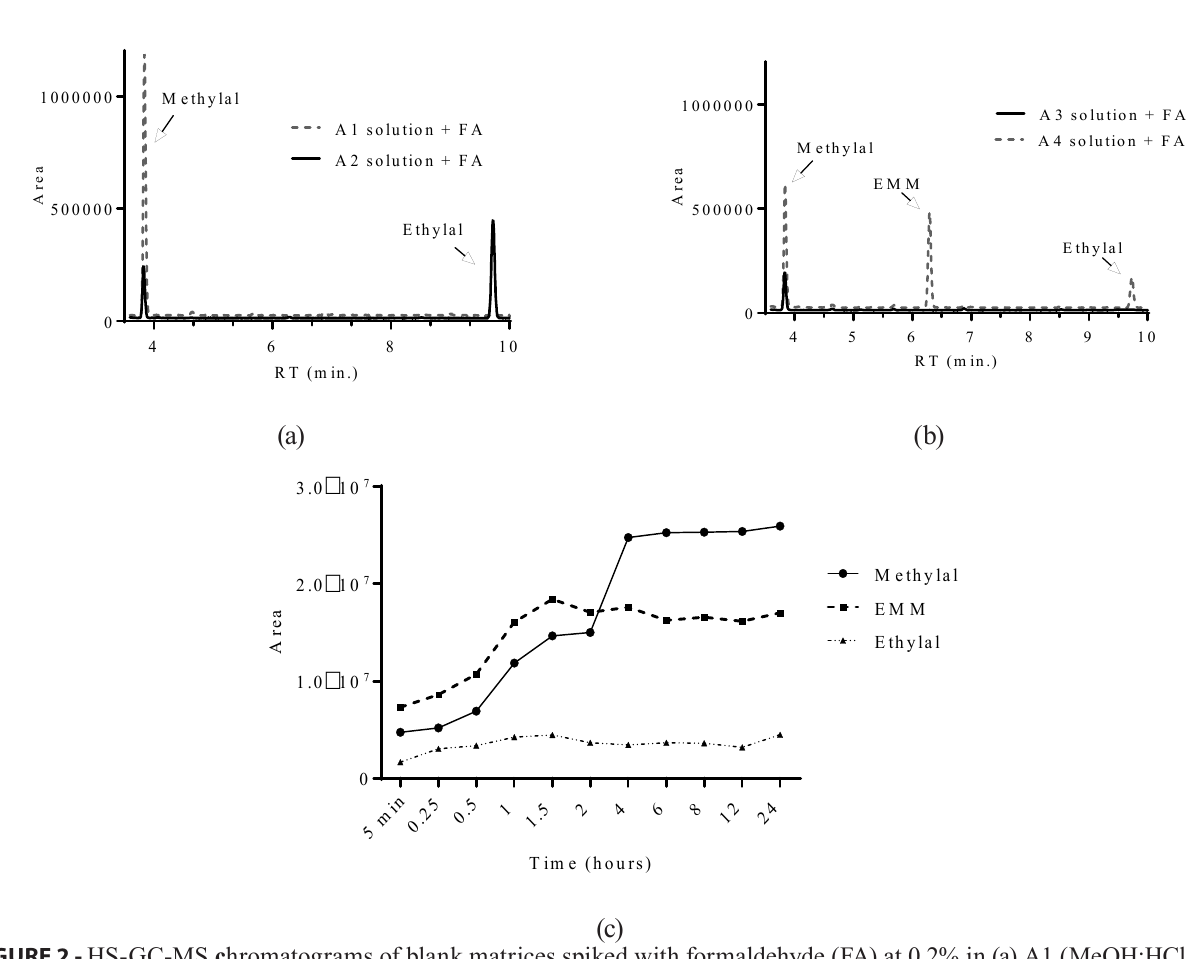
FIGURE 2 - HS-GC-MS c hromatograms of blank matrices spiked with formaldehyde (FA) at 0.2% in (a) A1 (MeOH:HCl, 50:1) and A2 (EtOH:HCl, 50:1) solutions; (b) A3 (MeOH:EtOH (25:25) and A4 (MeOH:EtOH:HCl, 25:25:1) solutions. (c) Kinetic for methylal, ethoxymethoxymethane (EMM), and ethylal formation at 60º